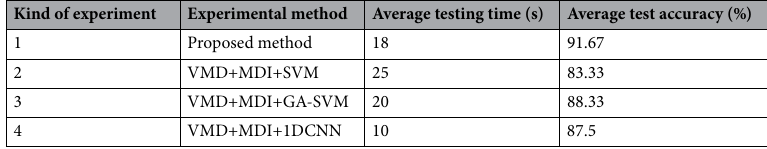
Table 5. Comparison of different fault classification methods.